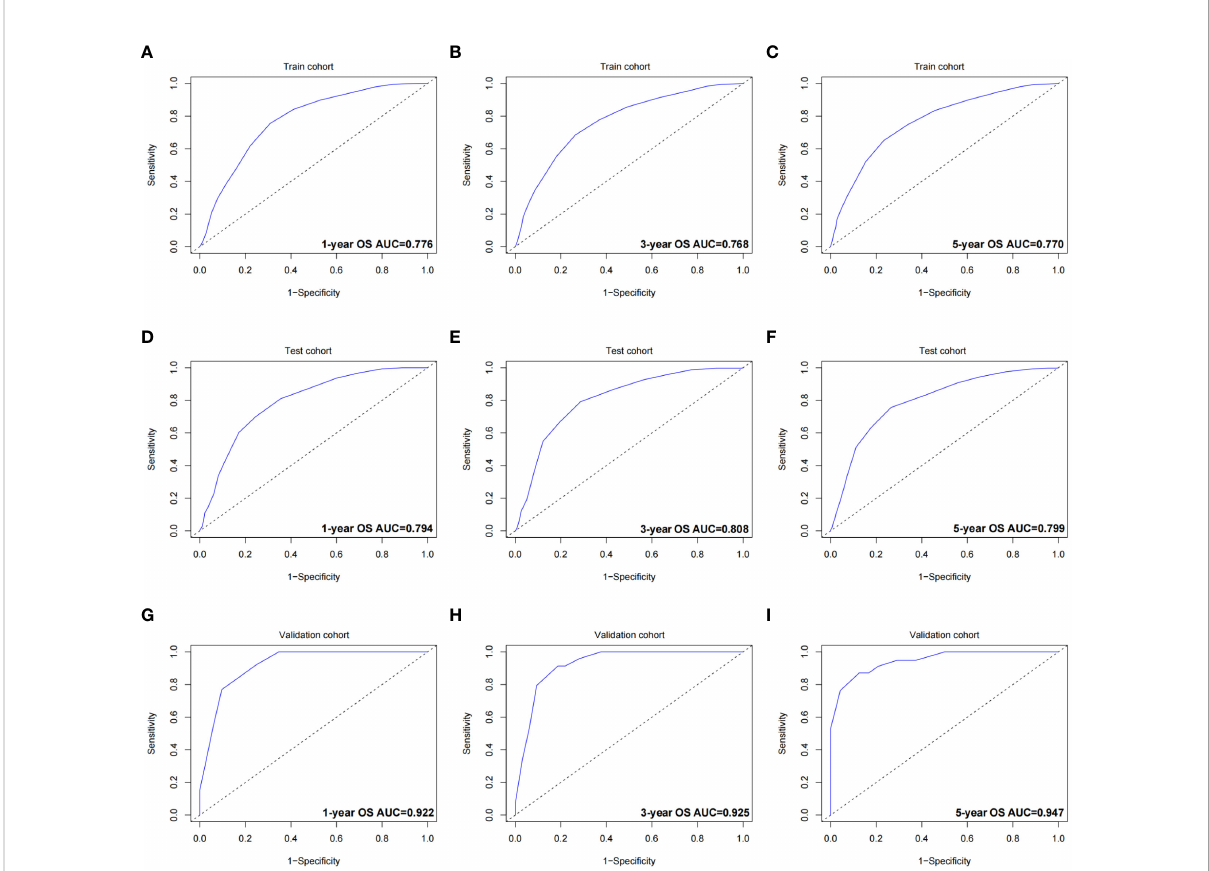
FIGURE 5 ROC curves of the OS nomogram. (A) 1-year ROC curve of the OS nomogram using train cohort. (B) 3-year ROC curve of the OS nomogram using train cohort. (C) 5-year ROC curve of the OS nomogram using train cohort. (D) 1-year ROC curve of the OS nomogram using the test cohort. (E) 3-year ROC curve of the OS nomogram using the test cohort. (F) 5-year ROC curve of the OS nomogram using the test cohort. (G) 1-year ROC curve of the OS nomogram using the validation cohort. (H) 3-year ROC curve of the OS nomogram using the validation cohort. (I) 5-year ROC curve of the OS nomogram using the validation cohort. ROC, receiver operating characteristic curve; OS, overall survival; AUC, area under the